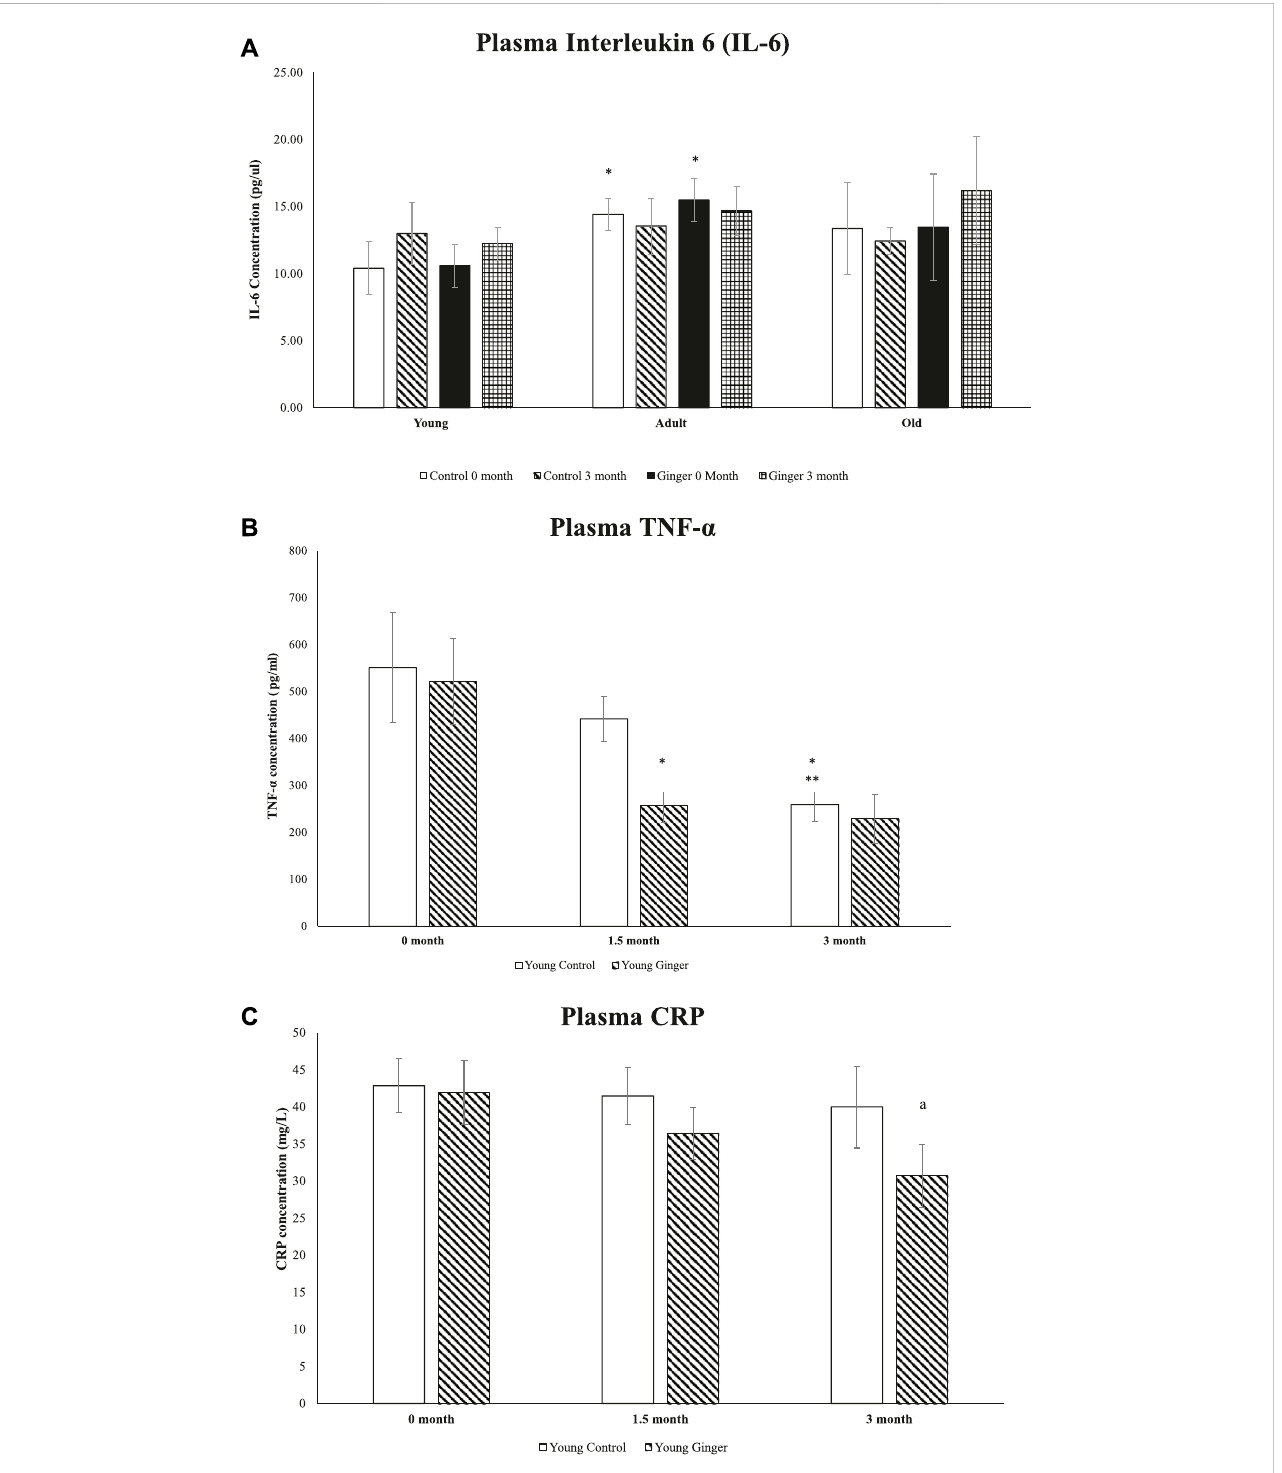
FIGURE 9 Plasmainterleukin6(IL-6)levelsinyoung,adult,andoldrats(A),plasmalevelsofTNF- α (B) andCRP(C)inyoungrats.Thedatawerepresentedasmean± SD.* p < 0.05 signi fi cantly different compared to young control rat at 0 month, ** p < 0.05 signi fi cantly differentcomparedto young control rat at1.5 months, a p < 0.05 signi fi cantly different compared to untreated rats at respective